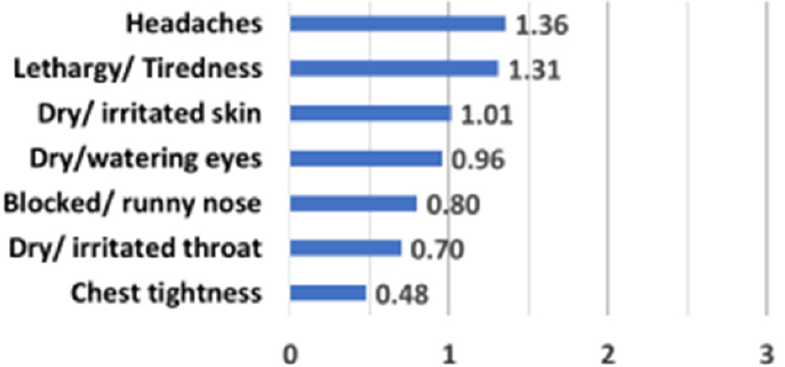
Figure 8. Frequency scores of sources contributing to discomfort and dissatisfaction toward thermal comfort.